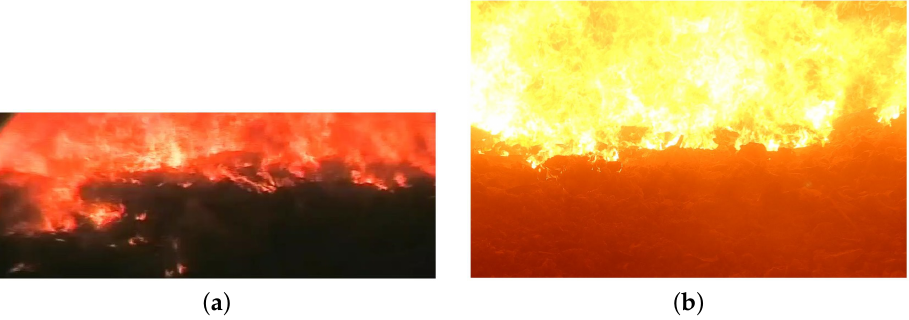
Figure 9. The reference image and source image of MSWI. ( a ) Source Image; ( b ) Reference Image.